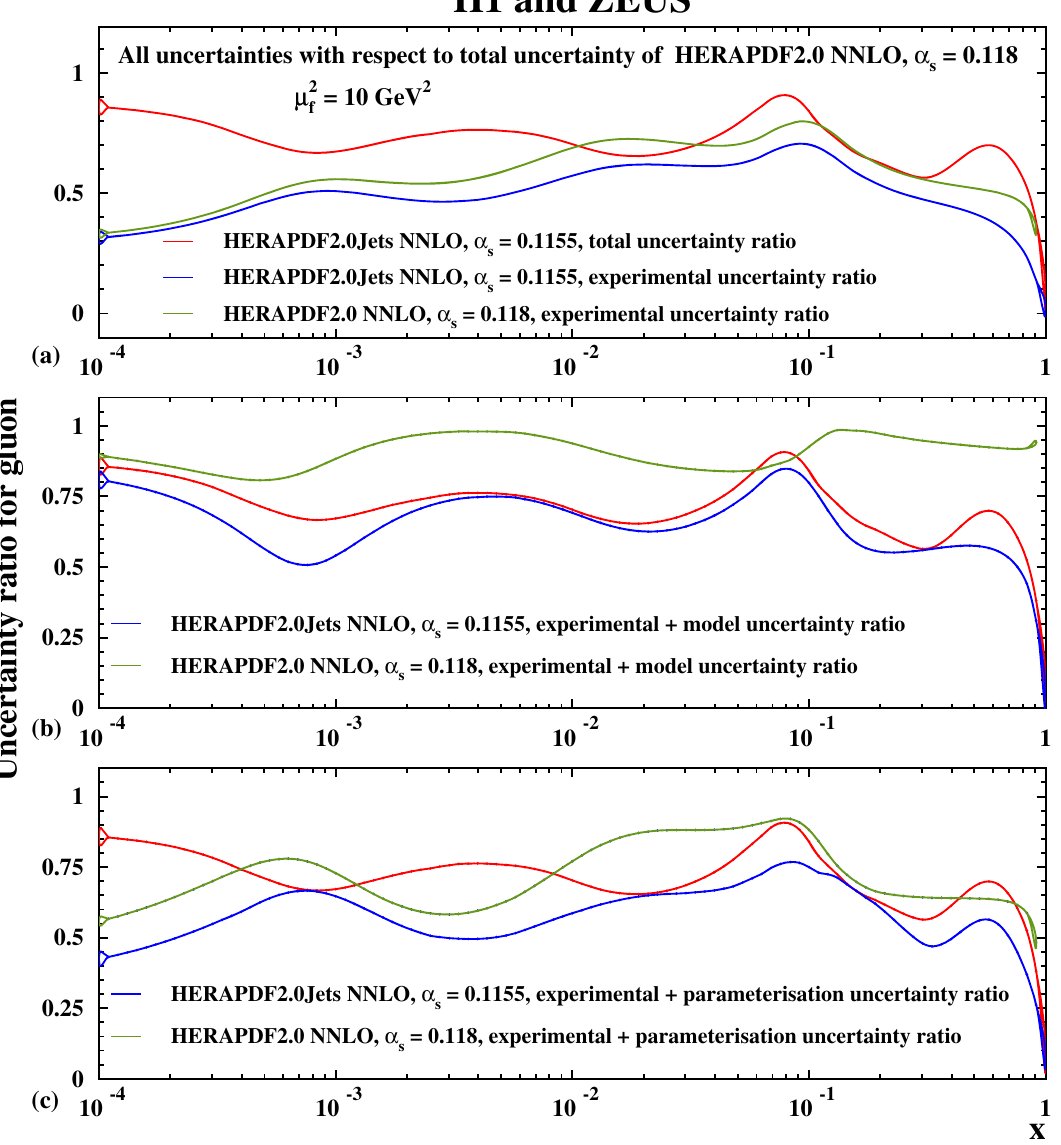
) = 0 . 1155 Z ) = 0 . 118 at the scale Z